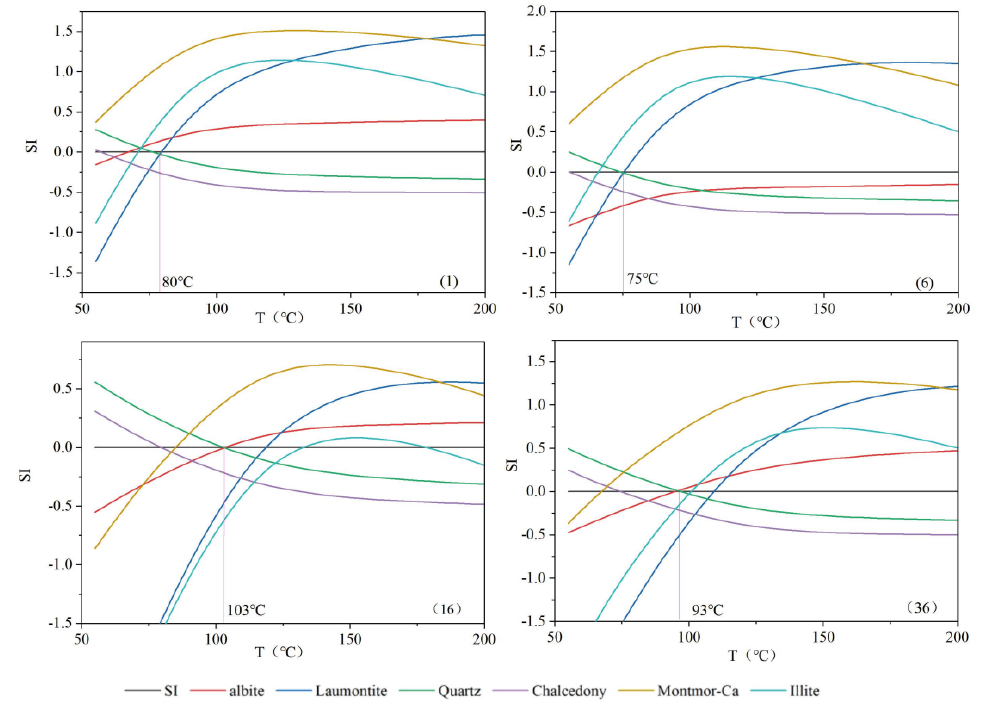
Figure 4. SI-T diagram for geothermal fluids (note: vertical lines are multiple minerals with SI values at this temperature intersecting at SI = 0, using this temperature as the geothermal reservoir temperature).